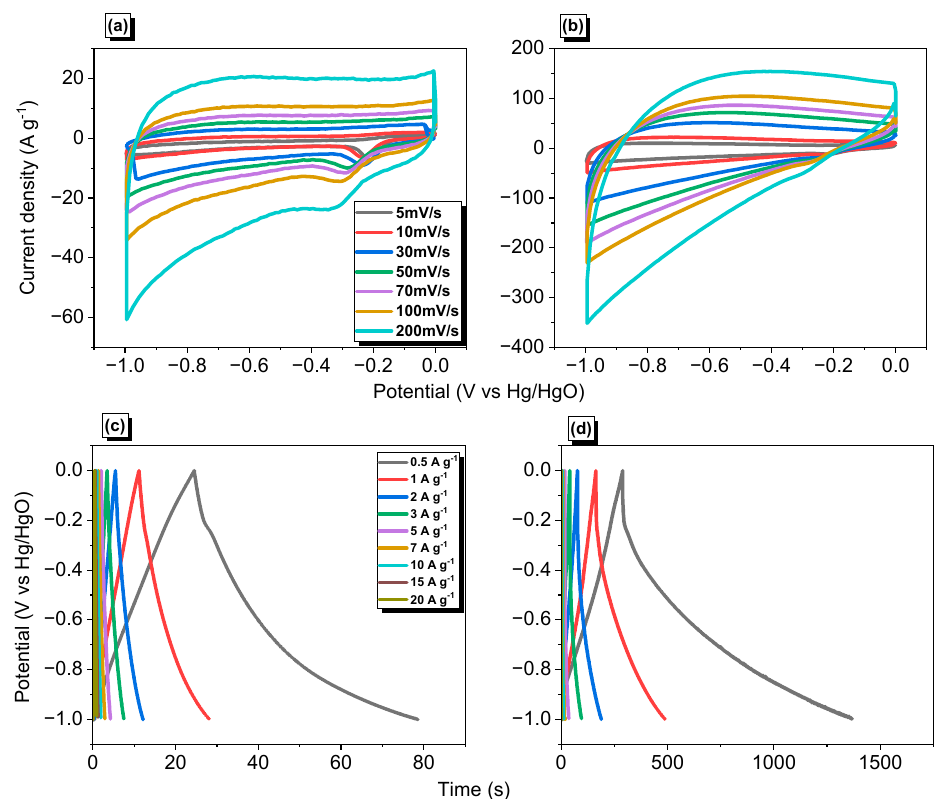
Figure 7. CV ( a , b ) and GCD ( c , d ) profiles of Py-PDT POP ( a , c ) and Py-PDT POP-600 ( b , d ). As we expected, the specific capacitance of Py-PDT POP-600 at a current density of 0.5 A g − 1 was 550 F g − 1 , which was considered to be much higher than Py-PDT POP (28 F g − 1 at 0.5 A g − 1 ) (Figure 8a). We compared our Py-PDT POP-600 with other carbon porous materials and their derivatives, such as carbons derived from peach gum, hollow carbon–MoS 2 carbon nanoplates, lignin-based and cellulose hydrogels, carbon composite and replicas obtained from a hybrid layered double hydroxide active container, tannic acid (TA), and carbon nanotubes (CNTs), and others [61,69–80]. The electrochemical performance of our Py-PDT POP-600 displayed an excellent electrochemical character (Table S1) [61,69–80]. The superb performance of Py-PDT POP-600 in energy storage applications was due to its high N content, surface area, pore volume, pore size, and prolonged conjugated structure [61,68]. The long-term stability of Py-PDT POP and Py- PDT POP-600 was investigated through cycling processes for 2000 cycles at a current density of 10 A g − 1 . As shown in Figure 8b, both Py-PDT POP and Py-PDT POP-600 showed capacitance retention of 84 and 96%, respectively. Accordingly, the Ragone plots of our materials (Figure 8c) emphasized that Py-PDT POP-600 possessed a maximum energy density of 76.38 Wh Kg − 1 , which was higher than pristine Py-PDT POP, which was 3.77 Wh Kg − 1 . Electrochemical impedance spectroscopy (EIS) investigations of the Py-PDT POP- and Py-PDT POP-600-based electrodes helped us to emphasize their kinetic behaviors. Nyquist graphs of the Py-PDT POP and Py-PDT POP-600 precursors implied small semi- circles at higher frequencies and a semi-straight line at lower frequencies (Figure 8d). The latter represented a lower resistance than the former, which revealed the lower resistance of Py-PDT POP-600. The lower resistance of Py-PDT POP-600 may have been due to the higher offering surface area of the electrode, consequently improving the surface wettability; hence, this enhanced the access of electrolyte ions to the current